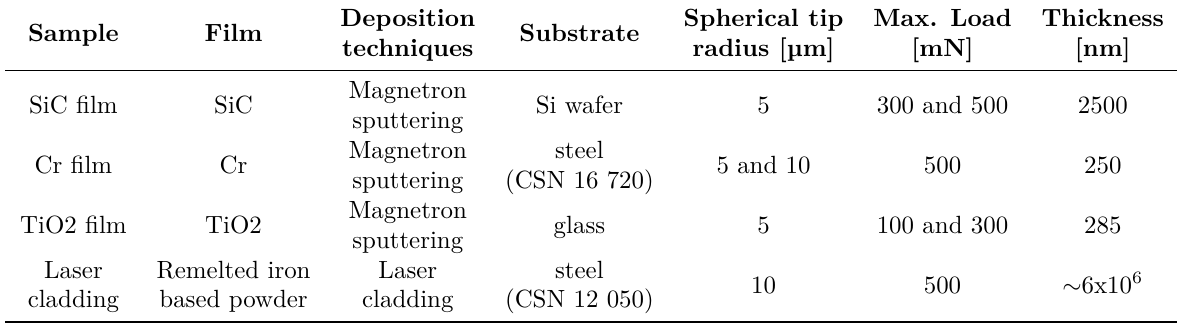
Table 1. Overview of tested samples and experimental conditions used in this